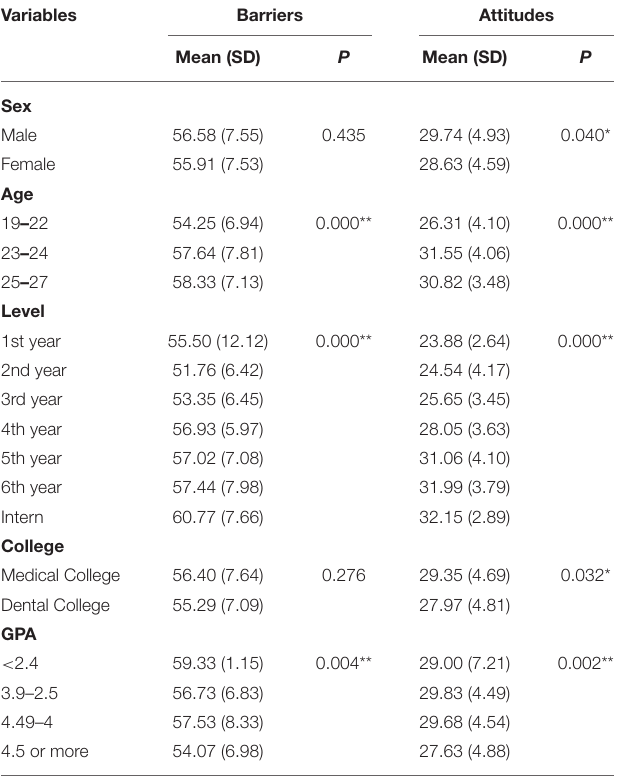
TABLE 6 | The relationship between demographic characteristics and attitudes and perceived barriers toward research.